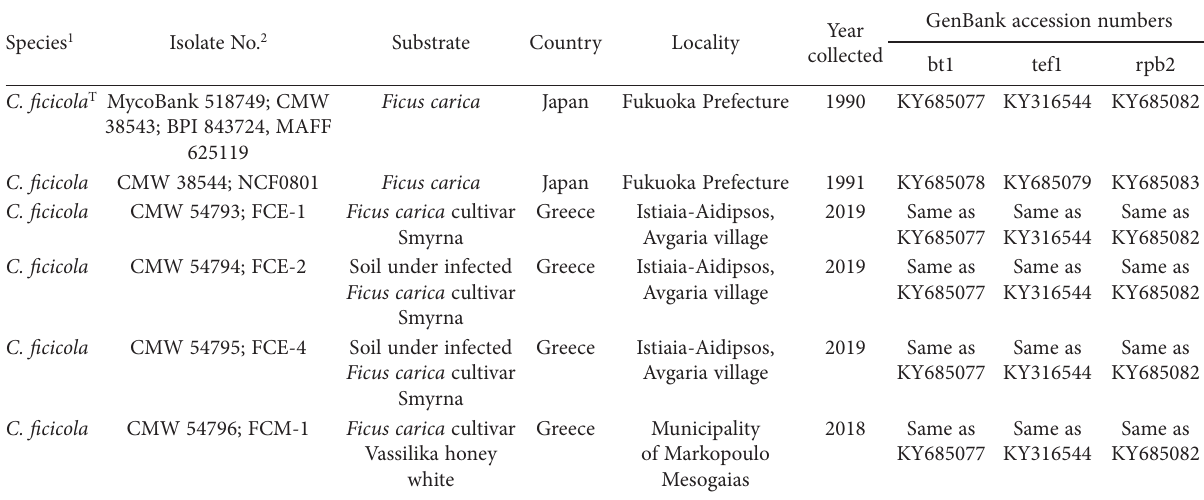
Table 2. Details of the Ceratocystis ficicola isolates from Japan and Greece analysed in the present study. Species 1 Isolate No. 2 Substrate Country Locality